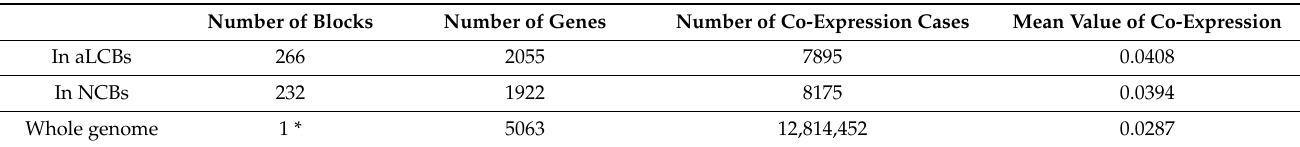
Table 3. Comparison of the co-expression rates of genes from different regions of the genome. NCBs are for regions that are situated outside the aLCBs. * We handled the whole genome as one large block of